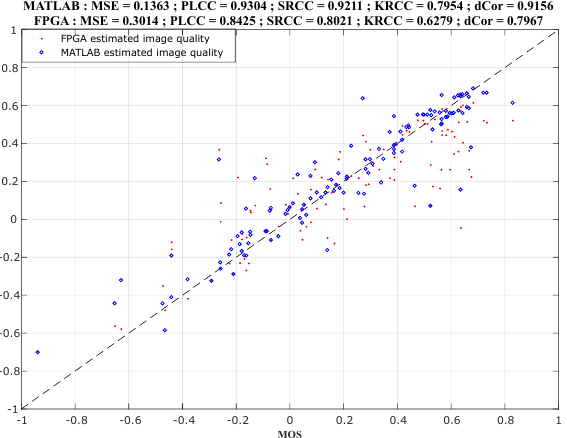
Figure 8. Comparison between MATLAB and FPGA implemented scores.